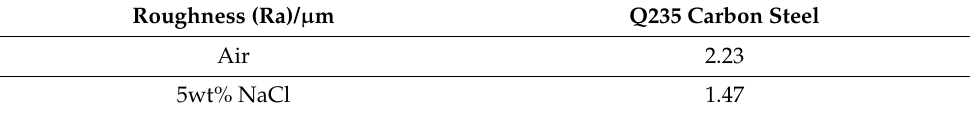
Table 5. Fatigue fracture surface roughness of Q235 carbon steel in air and 5wt% NaCl. Roughness (Ra)/μm